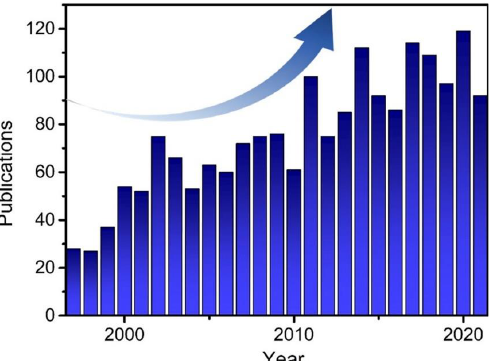
Figure 2. The number of publications regarding gel dosimeters from 1997 to February 2022, which was searched in Web of Science using Gel AND dosimet* as the topic.